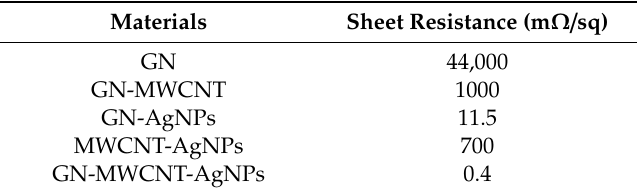
Table 1. Sheet resistance of films coated with different materials.